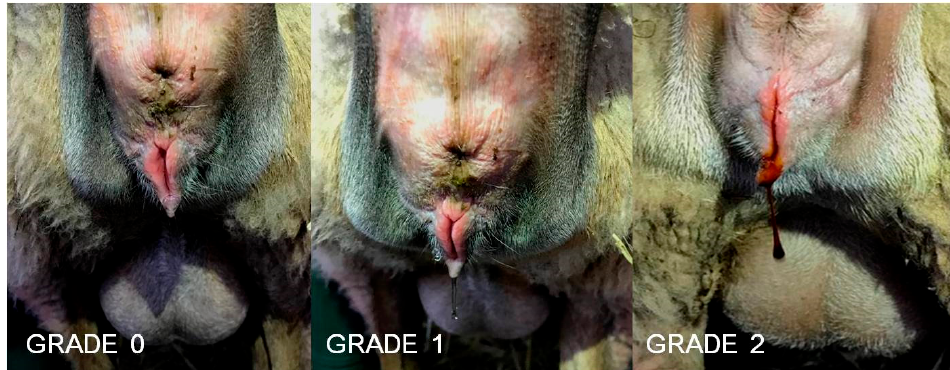
Figure 1. Scoring of vaginal discharge at intravaginal device removal: 0—negligible or no discharge; 1—some amount but clear discharge; 2—abundant amounts and hemorrhagic or